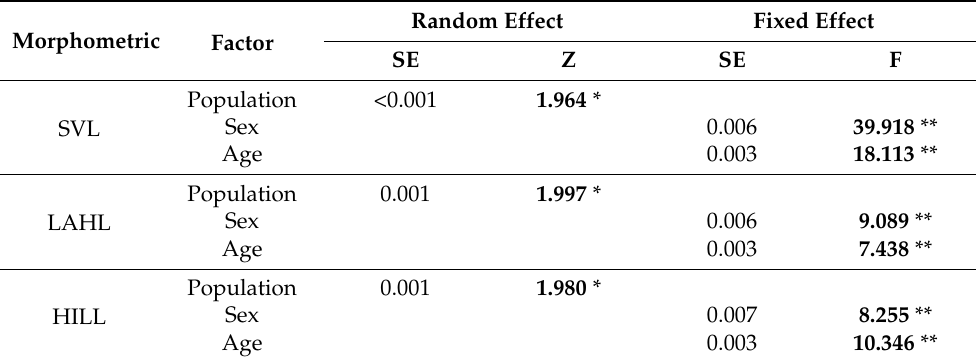
Table 1. The effects of sex and age on Rana kukunoris morphometrics. Statistics were calculated with linear mixed model, incorporating morphometrics as dependent variable, sex as fixed factor, population as random effect, and age was added as covariate. Results are shown as standard error (SE), z score (Z), and f value